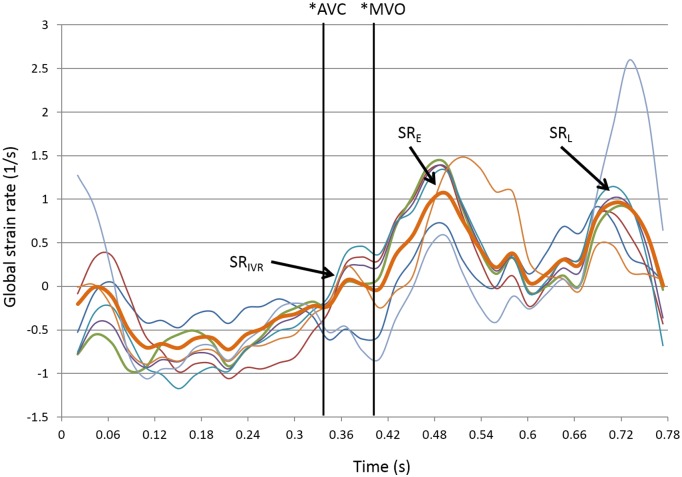
Speckle tracking, strain, and strain rate.Averaged global strain rate signal (in brown) using 2D speckle tracking. Notice the strain rate (SR) during the isovolemic relaxation time (*), early diastole phase, and late diastole phase. AVC, aortic valve closure; MVO, mitral valve opening; SRIVR, global SR during the isovolumetric relaxation period; SRE, global SR during early LV filling; SRL, global SR during late LV filling.